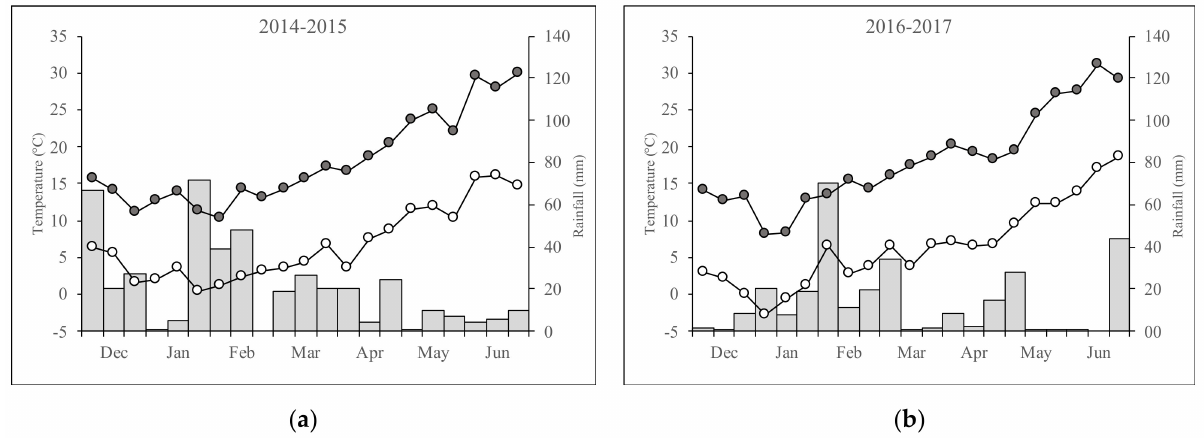
Figure 1. Air minimum (white dots) and maximum (black dots) temperatures and rainfall (bars) in the two